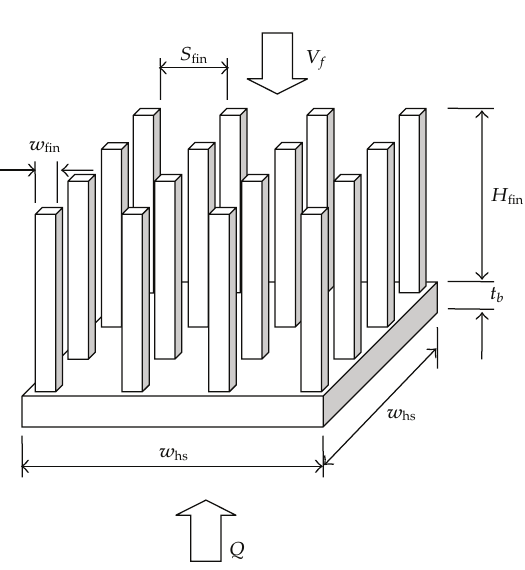
Figure 2: Physical model of pin-fin heat